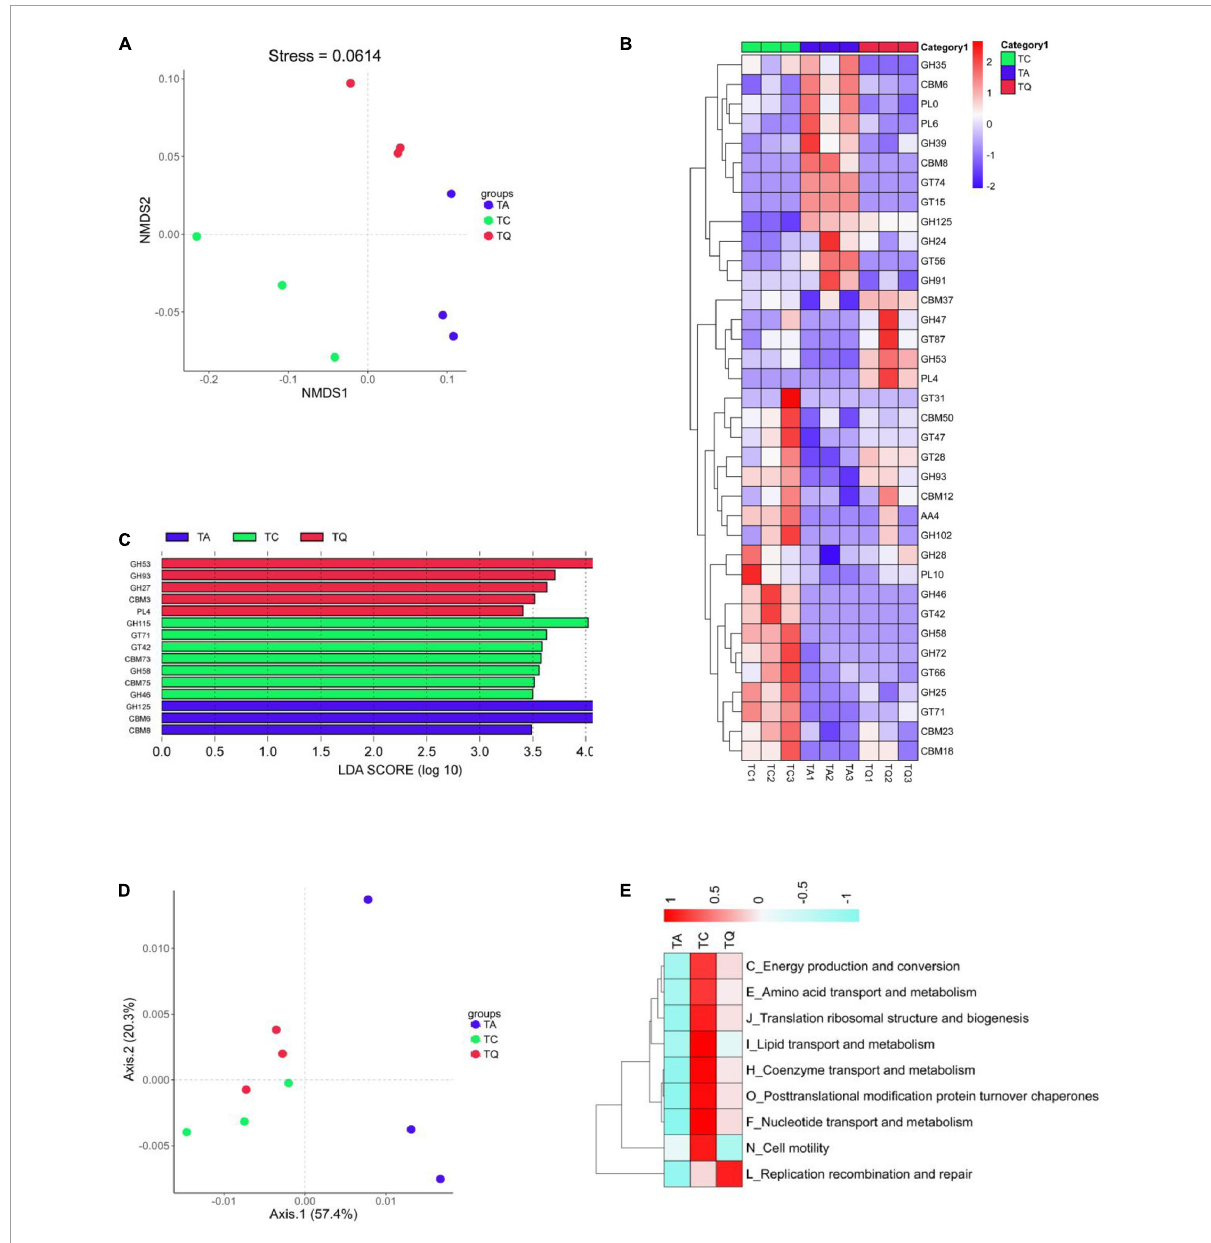
FIGURE5 Functional analysis based on CAZy orthologs and egg NOG Orthologous. (A) NMDS analysis of CAZy function was clearly separated within groups; (B) Significantly different enzymes within groups; (C) LDA analysis of significantly different enzymes; (D) PCoA analysis of NOGs function was clearly separated within groups; (E) NOGs based significantly different metabolic pathway within